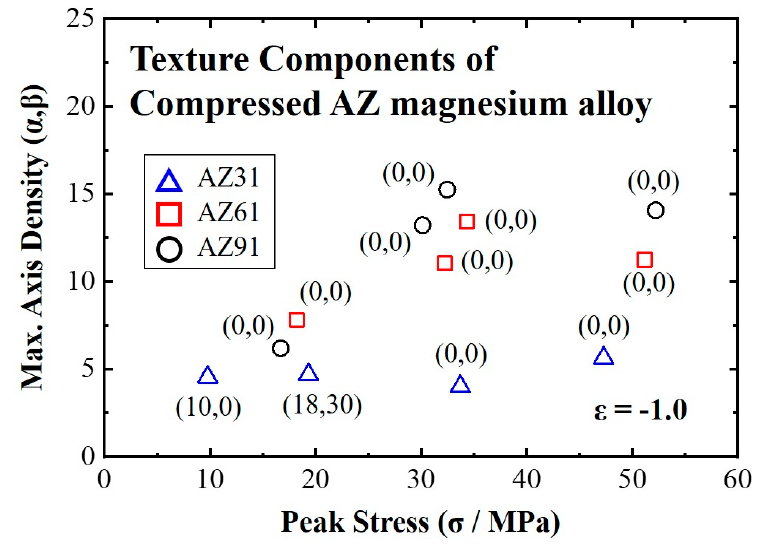
Figure 8. The components and intensities of deformed texture according to the peak stress.